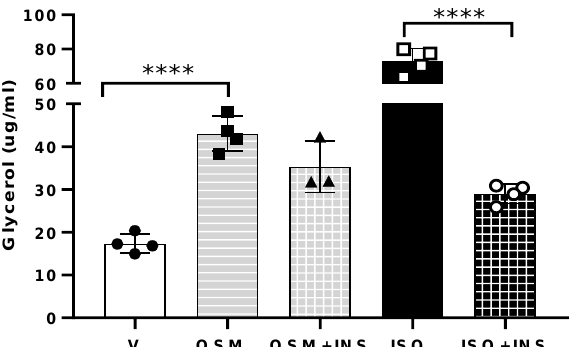
Figure 1. OSM induces lipolysis and partially inhibits its suppression by insulin. Lipolysis assays were conducted in fully differentiated 3T3-L1 adipocytes. Cells were pretreated with OSM overnight and, the following morning, were incubated in medium containing phosphate buffered saline (PBS) + 0.1% bovine serum albumin (BSA) as the vehicle control (V), 0.5 nM OSM, 0.5 nM OSM + 17.5 nM bovine insulin (INS), 2 nM isoproterenol (ISO) as a positive control, or ISO + INS (as a positive control for insulin suppression), for 6 h. Glycerol measurements were obtained from 50 µ L media from each well (n = 3–4 wells per condition). OSM robustly stimulated lipolysis. This effect was maintained in the presence of insulin, suggesting that OSM inhibits the insulin-induced suppression of lipolysis. This experiment was conducted twice on separate batches of adipocytes. Significant differences are denoted as follows: **** p < 0.0001 between groups; bars represent mean ± SEM.